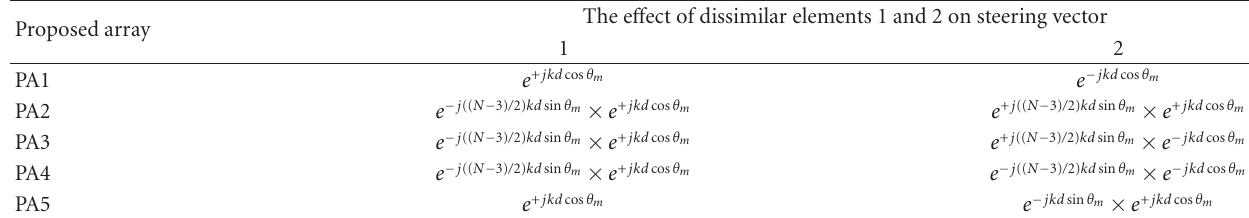
Table 1: The e ff ect of dissimilar elements in steering vector for di ff erent proposed arrays. The e ff ect of dissimilar elements 1 and 2 on steering Proposed array